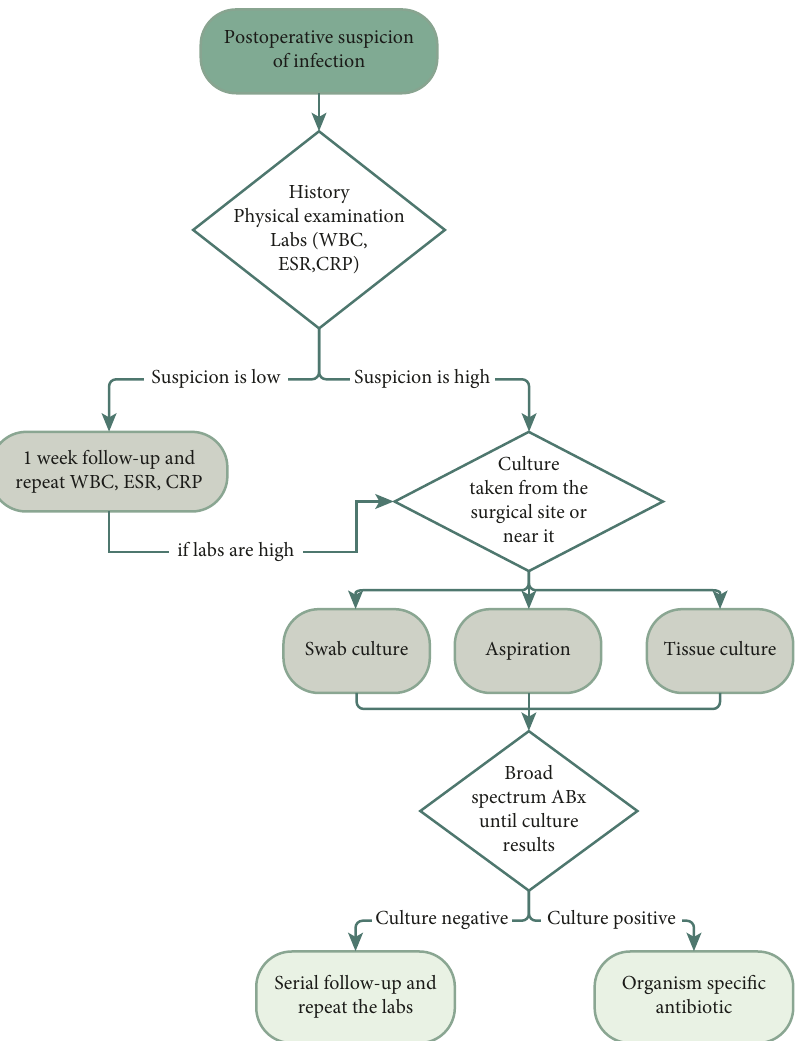
Figure 1: Management protocol in patients with suspicion of postoperative